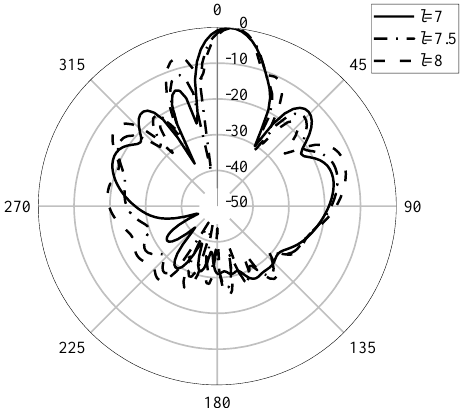
Figure 9. The simulated co-polarization radiation patterns in the E plane at 28 GHz versus l.